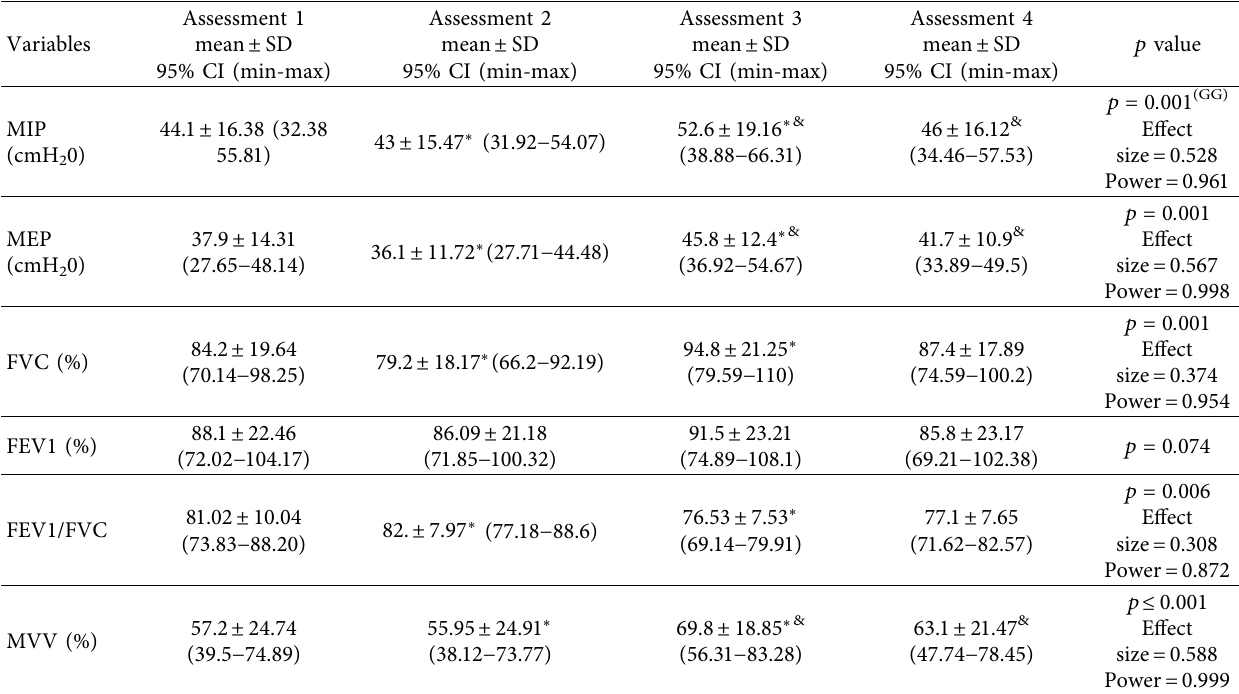
Table 6: Respiratory variables per assessment period.